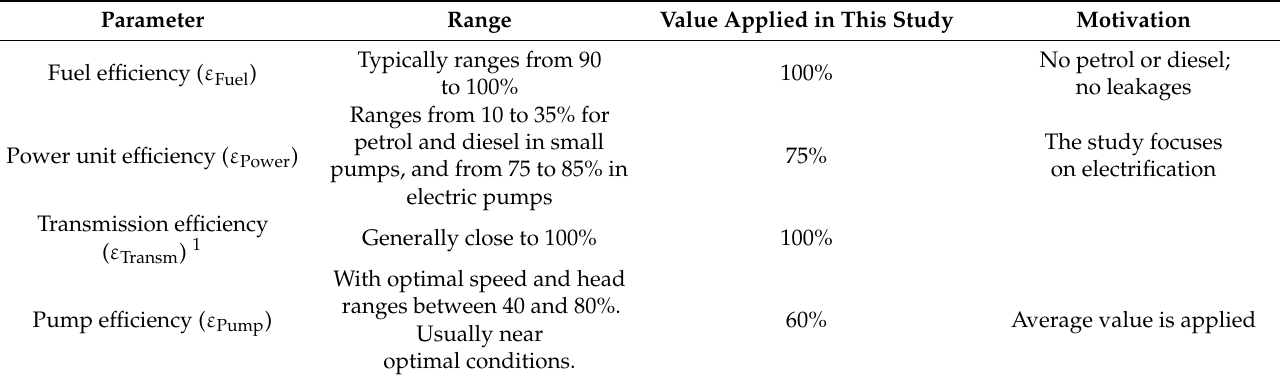
Table 7. Parameters considered in the overall pump efficiency. Data points are sourced from